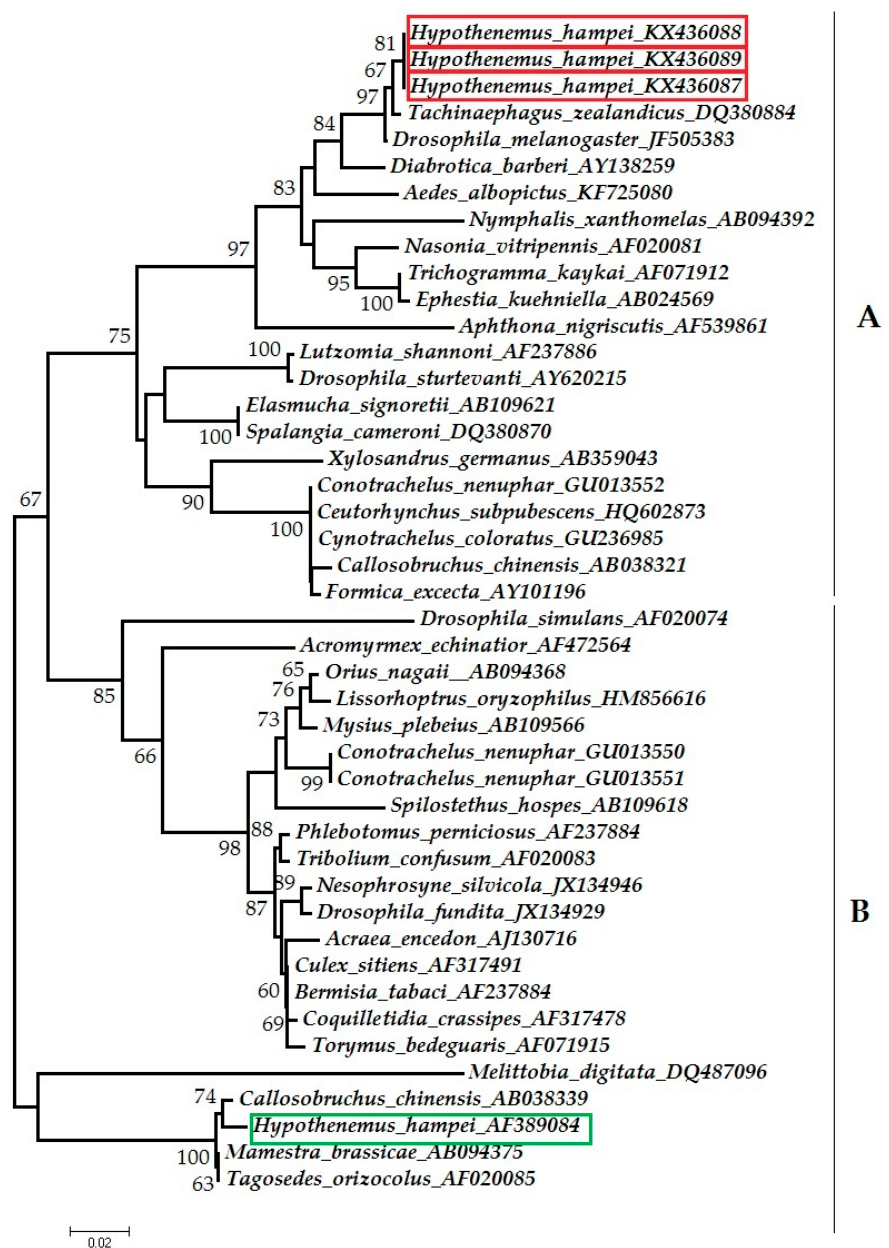
Figure 1. Neighbor-joining tree showing placement of wsp sequences of Wolbachia from Hypothenemus hampei in Wolbachia supergroups A and B. Sequences from this study are shown in red boxes; the sequence from H. hampei from Vega et al. [20] is shown in a green box. Reference sequences from endosymbionts of 41 species of insects are included. The tree was constructed using the Maximum Composite Likelihood model and midpoint rooted. Bootstrap probabilities >50% are shown at the nodes. GenBank accession numbers are shown.